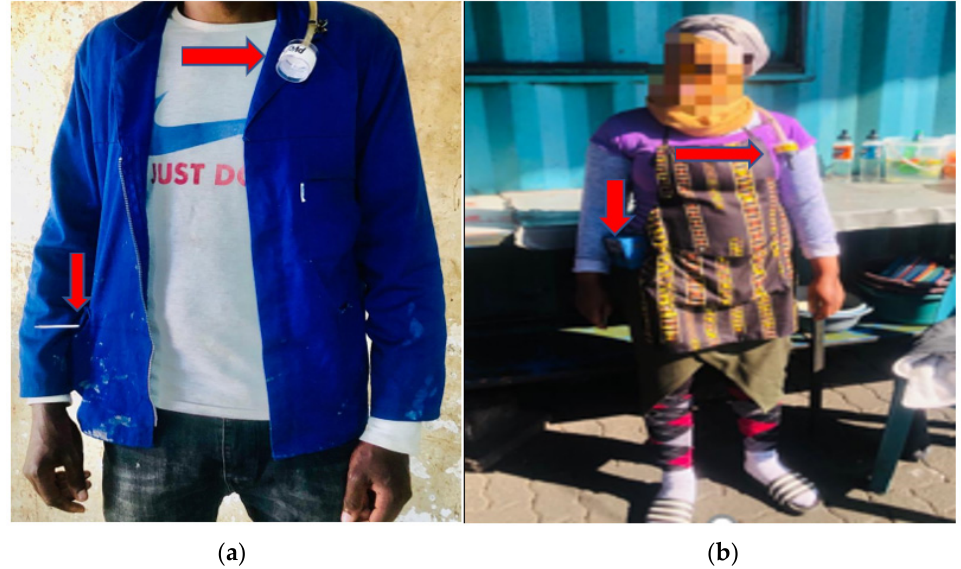
Figure 1. ( a ) An indoor informal cooking vendor wearing a sampling device. ( b ) An outdoor informal cooking vendor wearing a sampling device.